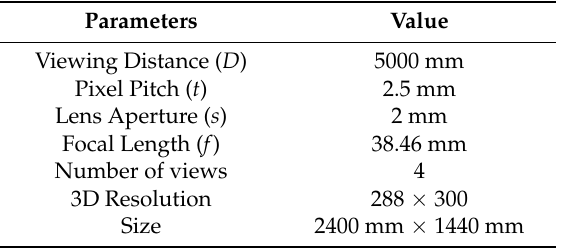
Table 1. Specifications of the autostereoscopic display